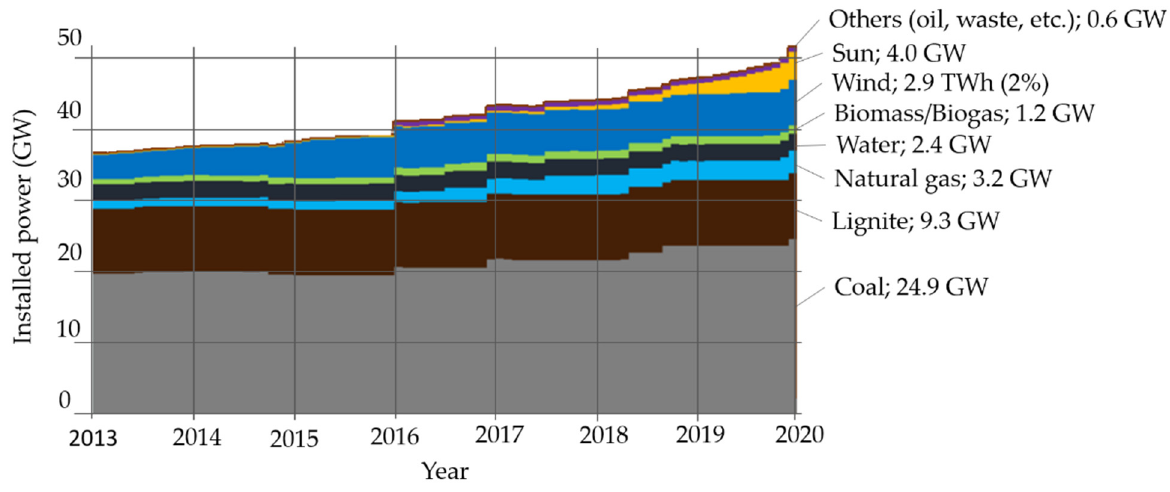
Figure 6. Power plant capacity in Poland through the years 2013–2020.